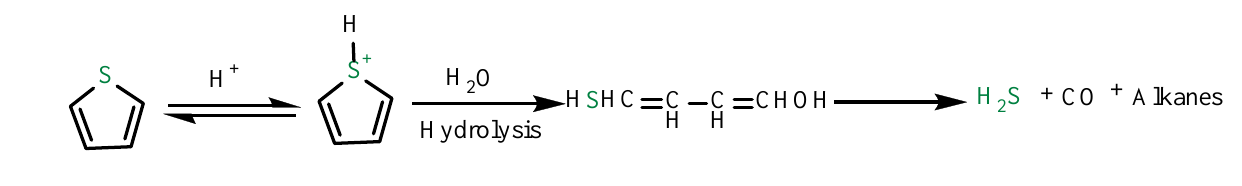
Table 6. The new compounds of thiophene under different reaction conditions.